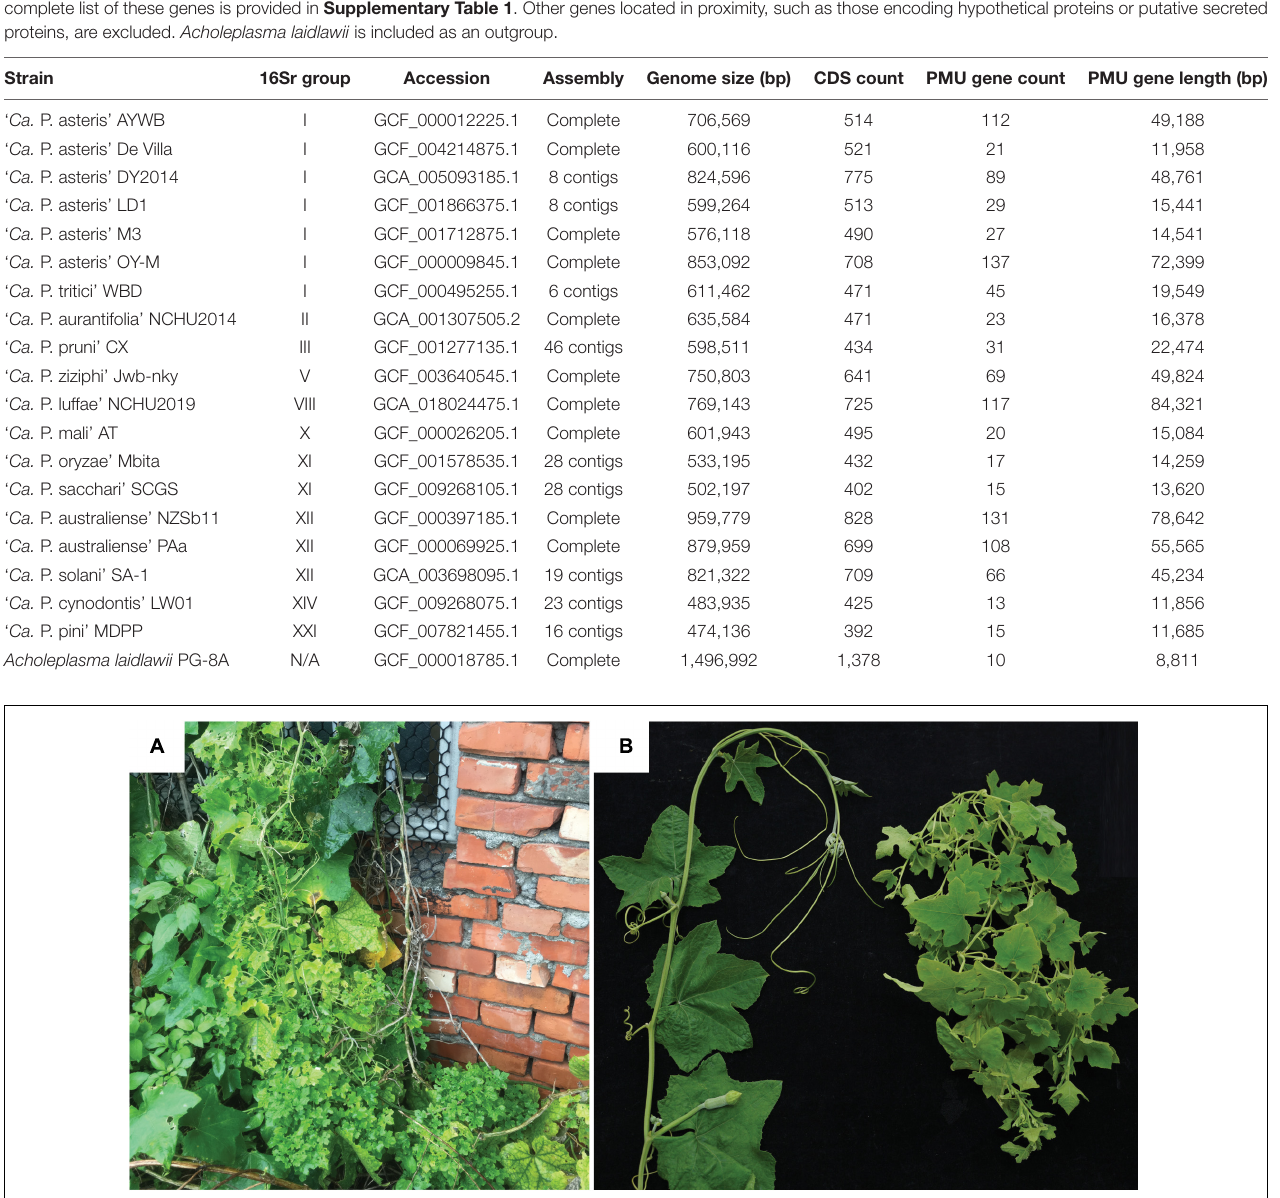
FIGURE 1 | Infection symptoms. (A) The loofah plant exhibiting phytoplasma infection symptoms that was collected in Changhua, Taiwan. (B) Loofah plants grown in the lab. Left, healthy control; right, grafted with the infected plant shown in panel (A)